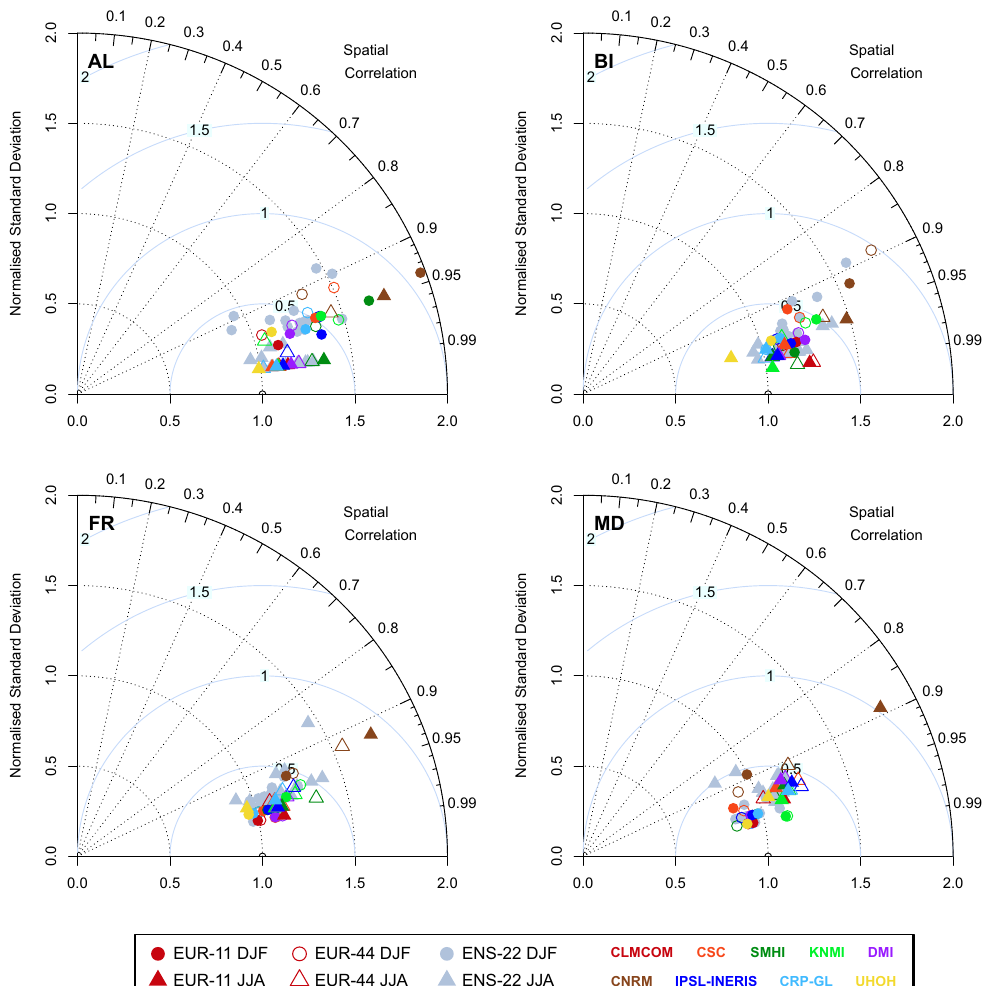
Figure B5. Spatial Taylor diagrams exploring the model performance with respect to the spatial variability of mean winter (circles) and mean summer (triangles) temperature within subdomains AL, BI, FR and MD (see Fig. 9 for subdomains EA, IP, ME and SC). Filled markers: EUR-11 ensemble, nonfilled markers: EUR-44 ensemble, gray markers: ENS-22 ensemble. The diagrams combine the spatial pattern corre- lation (PACO, cos(azimuth angle)) and the ratio of spatial variability (RSV, radius). The distance from the 1–1 location corresponds to the normalized and centered root-mean-square difference (which does not take into account the mean model bias), expressed as multiples of the observed standard deviation. Note the different number of underlying grid cells per subdomain in the individual